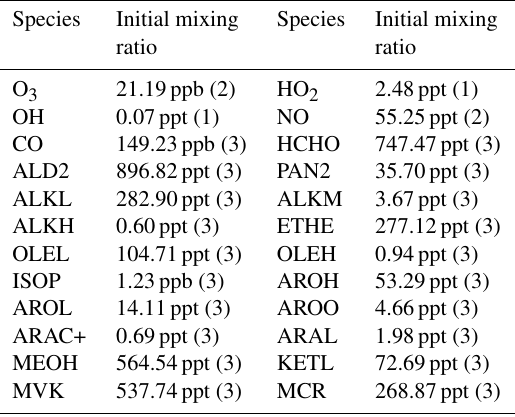
Table 1. Initial vertical profiles of mixing ratios and associated pro- files. Numbers in brackets refer to (1) uniform profile, (2) strato- spheric profile (initial profile multiplied by 1 from 0 to 2000m, then by 0.5 from 3000m to 13000m, by 0.75 at 14000m and 1 above), (3) boundary layer profile (multiplied by 1 from 0 to 1000m, by 0.10 from 2000 to 13000m and 0.05 above). Chemical names are those used in the ReLACS3 chemical mechanism. ALD2 corresponds to aldehydes C > 2, ALKL to lumped alkanes C 2 - C 6 , ALKM to lumped alkanes C 7 -C 12 , ALKH to lumped alkenes > C 12 , OLEH to lumped alkenes C > 6, ETHE to ethene, ISOP to isoprene, AROL to lumped low SOA yield aromatic species, AROH to lumped high SOA yield aromatic species, AROO to lumped phe- nolic species, ARAC+ to lumped aromatic monoacids, MEOH to methanol, ARAL to lumped aromatic monoaldehydes, MVK